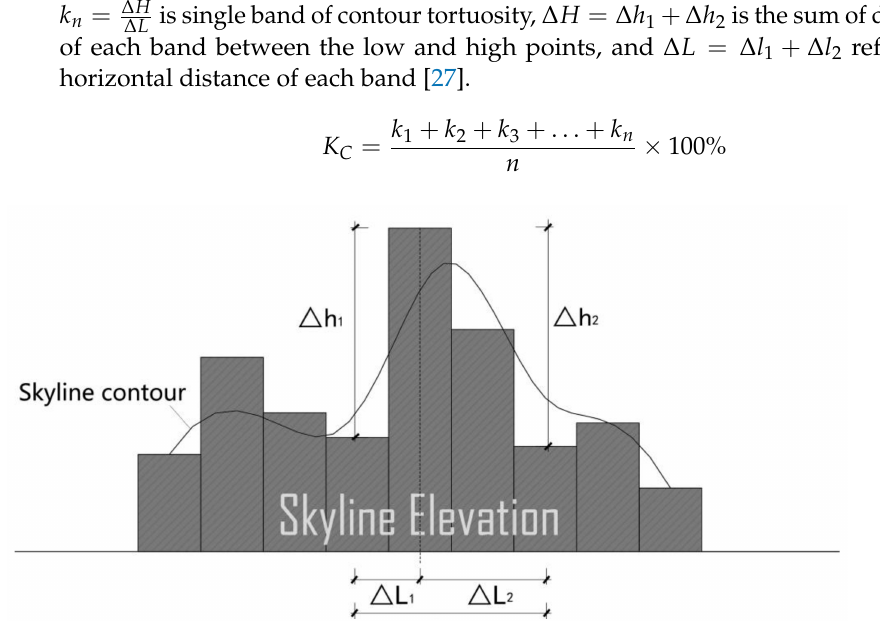
Figure 1. Contour